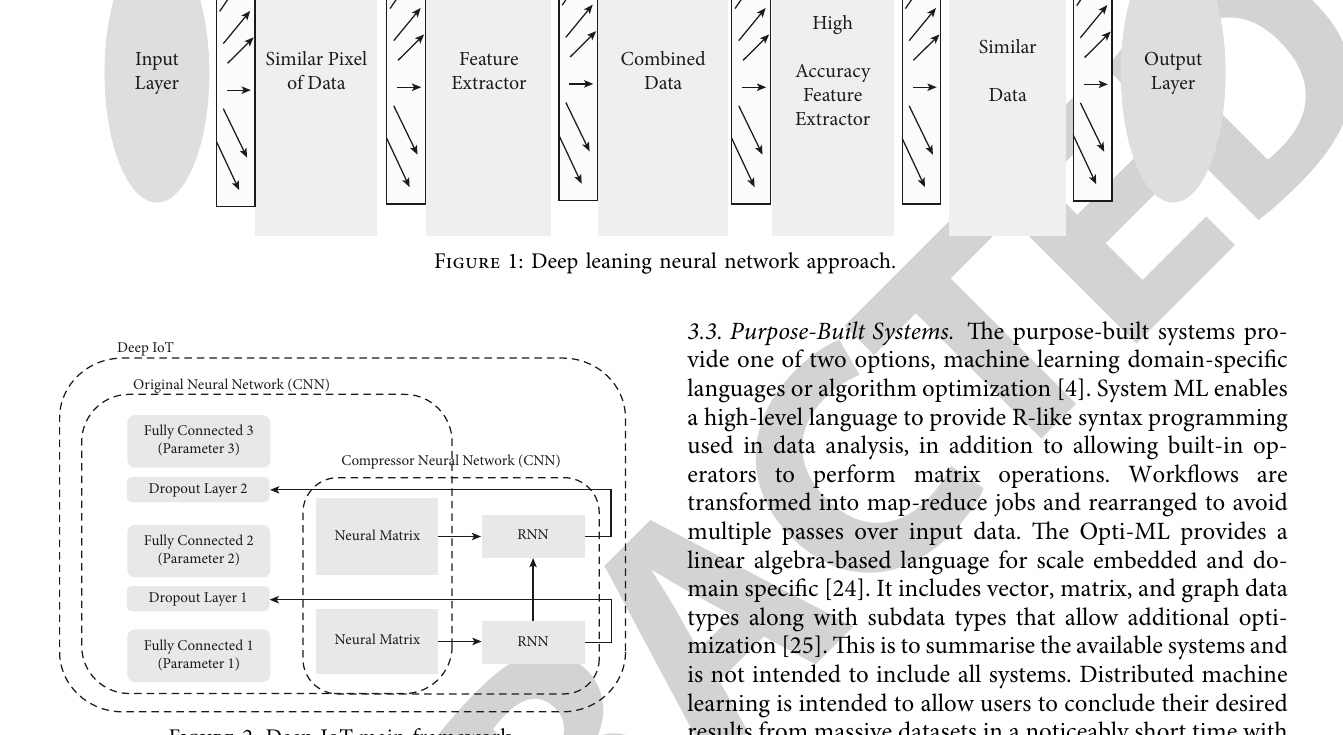
Figure 2: Deep IoT main